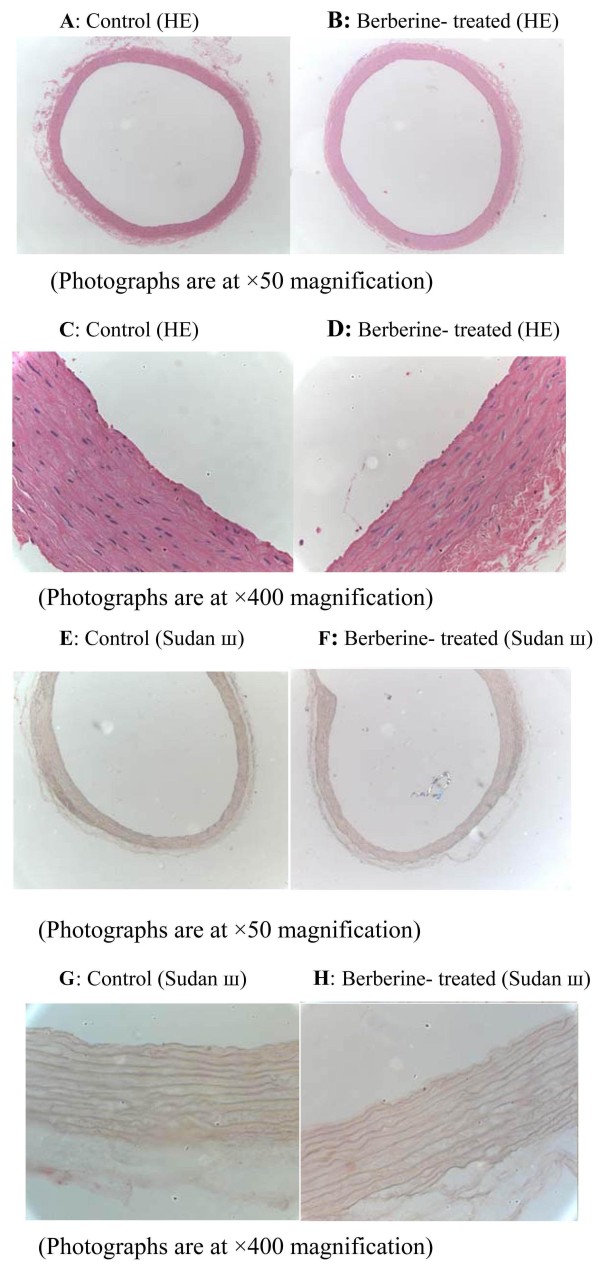
Effects of berberine (BBR) on the aorta of rats fed with a high-fat diet. After BBR treatment for 16 weeks, rats were killed after a 14-hour fast. Histological analysis of the aorta of the HFD-fed rats treated with vehicle (C group) or BBR (B group). The aorta sections were stained with hematoxylin and eosin (A-D) or with Sudan Ш (E-I) to evaluate the pathologic structures. Representative photographs are shown. A-B, E-F: Photographs are at × 50 magnification, C-D, G-H: Photographs are at × 400 magnification.